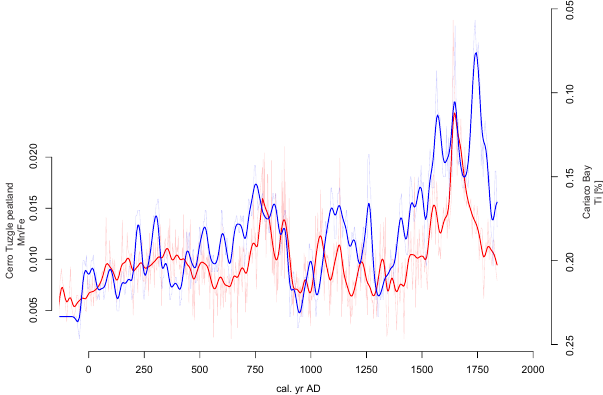
Figure 5. Comparison of the Mn / Fe ratio sequence of the CTP data set with reversed Ti values (Haug et al., 2001) at cross- correlation values >95% CI at a lag of 174 years, showing a corre- lation of r =